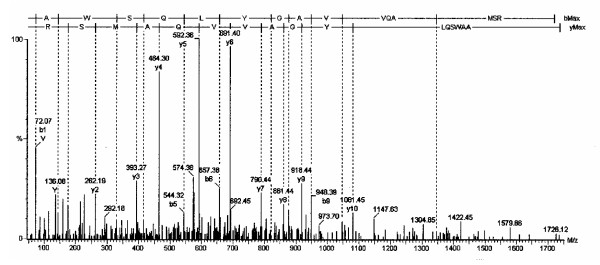
The tandem mass spectrum is shown for the neuroglobin amino acid 131 to 146 peptide.